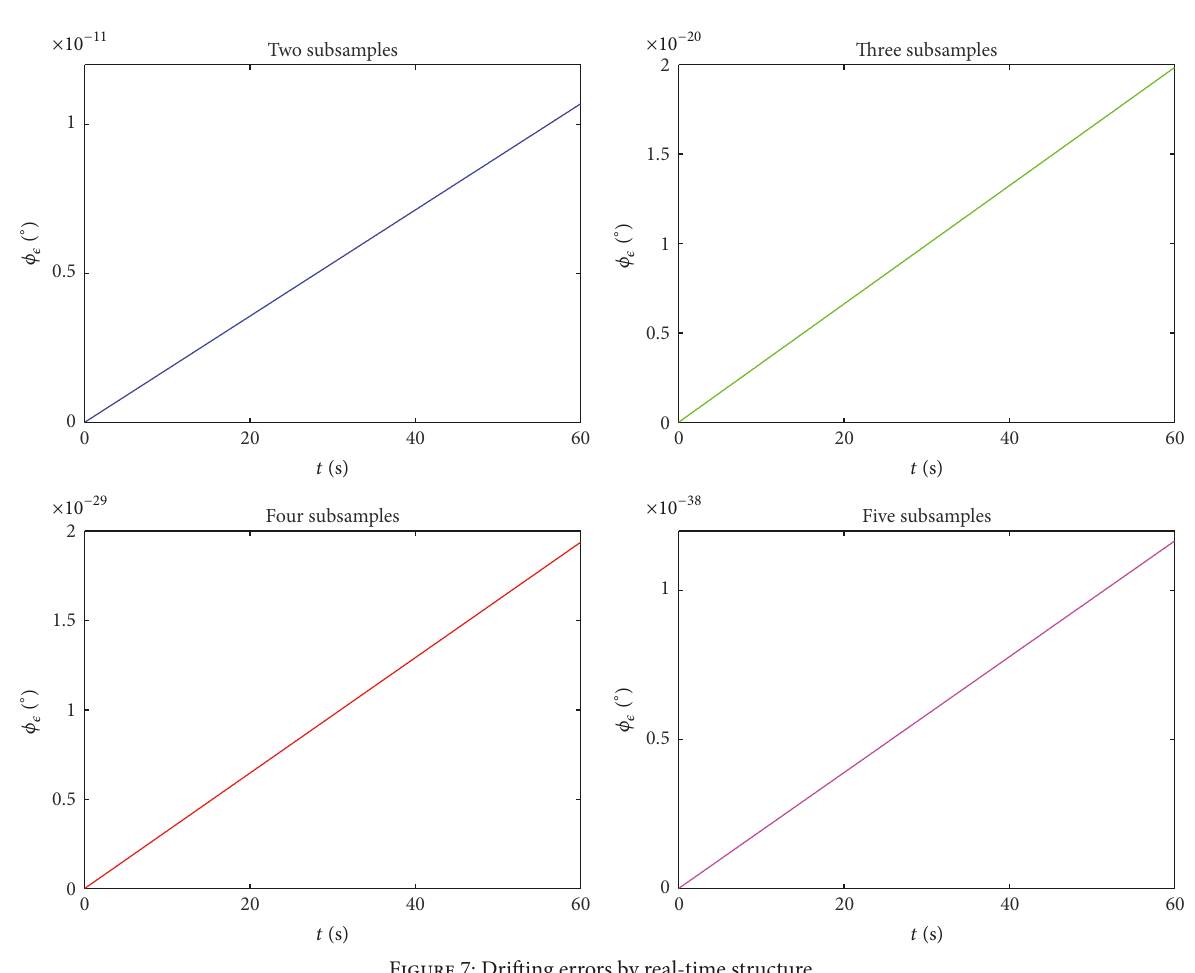
Figure 7: Drifting errors by real-time structure.